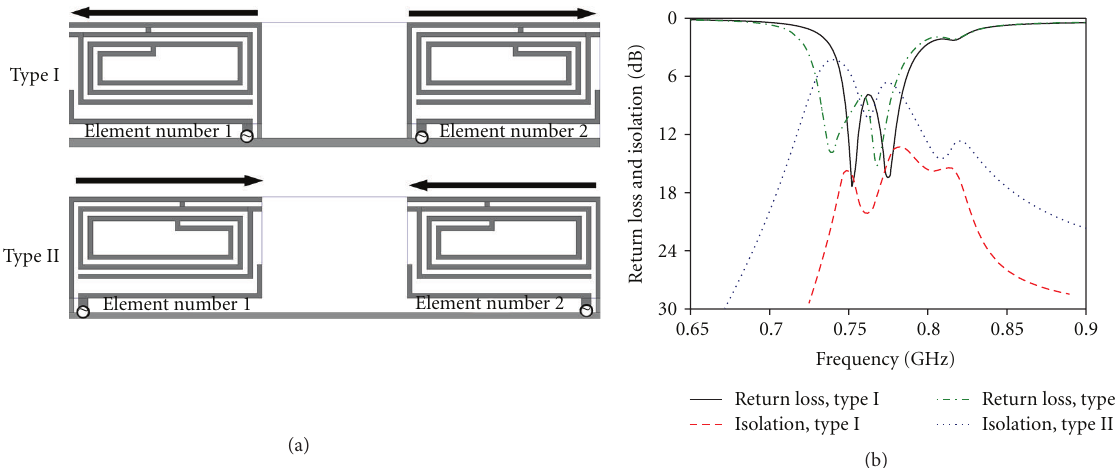
Figure 7: Return loss and isolation characteristics of the antenna with respect to a variation in the antenna element arrangement: (a) types of antenna arrangements and (b) return loss and isolation characteristics.